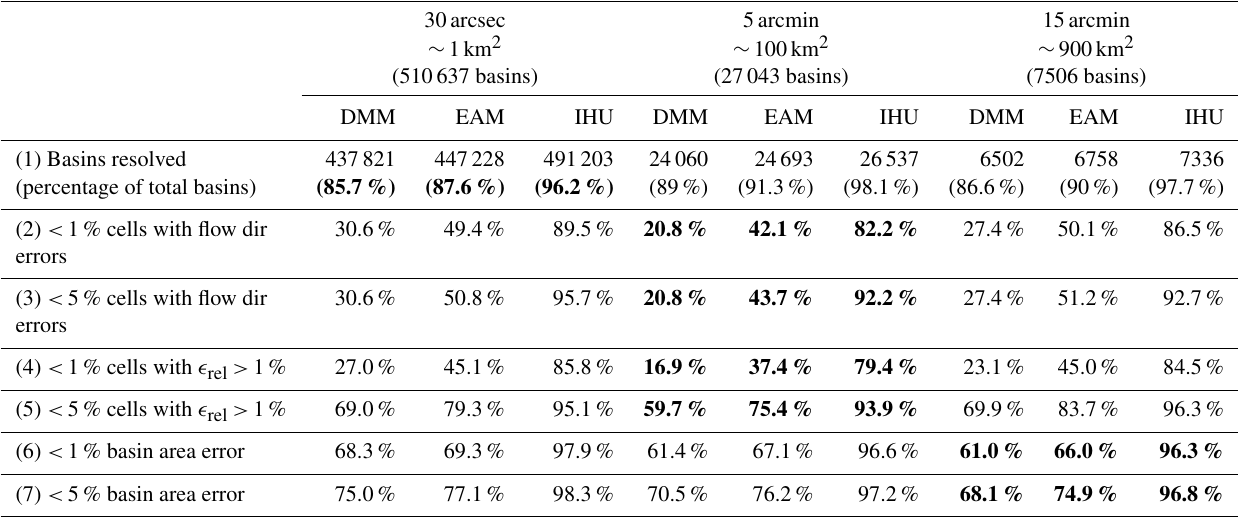
Table 2. Percentage of resolved basins with an area larger than approximately one cell that meet performance criteria based on relative basin area error, relative upstream area error ( (cid:15) rel ) larger than 1%, and cells with erroneous flow directions. For each criterion, the worst performance across all resolutions per method is highlighted with bold